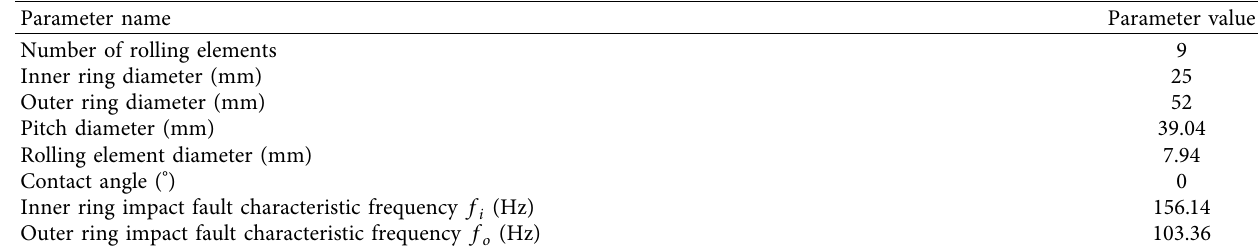
Table 3: Parameters of deep groove ball-bearing